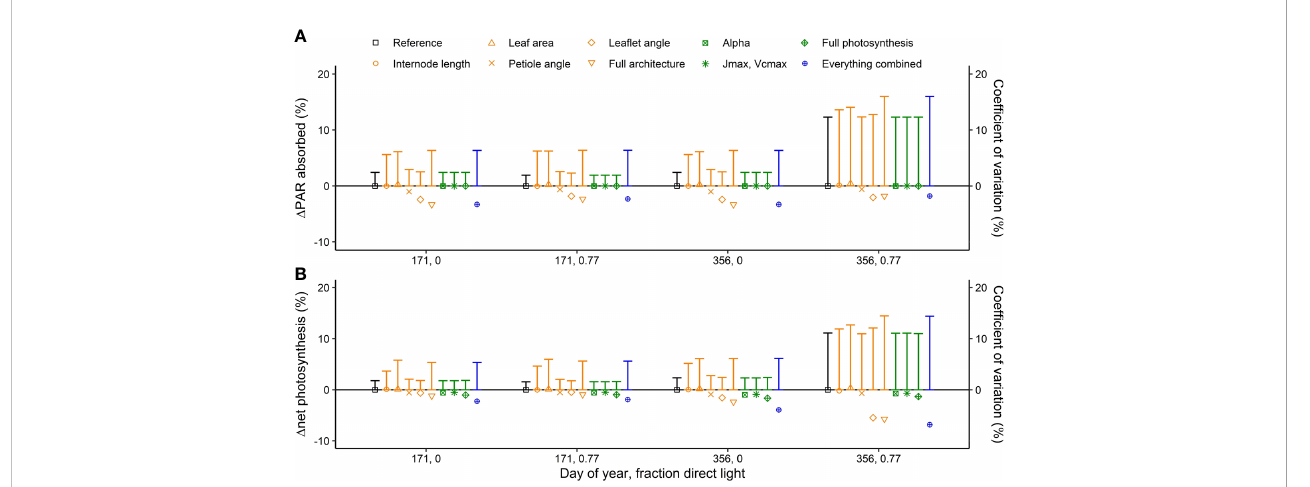
FIGURE 4 Simulated effects of interplant variation in architectural and photosynthesis traits on (A) canopy light absorption (symbols) and the coef fi cient of variation in plant light absorption (vertical bars) and (B) net photosynthesis (symbols) and the coef fi cient of variation in photosynthesis (vertical bars) at two fractions of direct sunlight (0 and 0.77) and at summer and winter solstices (DOY 171 and 356). Canopy light absorption and net photosynthesis are presented as % change compared to the reference where the rotation of plants relative to their neighbors (0 to 360 ◦ , drawn at random) was the only source of variation. The rotation of the plants relative to their neighbors was kept the same for every model simulation such that any differences in light absorption and net photosynthesis are the result of including interplant variation of architectural and/or photosynthesis traits. Data are the averaged values of all hourly time steps in a day of 24 plants (centre 12 plants of the centre two double rows) from fi ve repetitions (simulations with each a different random number generator for the light model and drawings from the normal distribution) and three different planting densities (1.5, 2.4 and 3.3 plants m − 2 , resulting in a total of 360